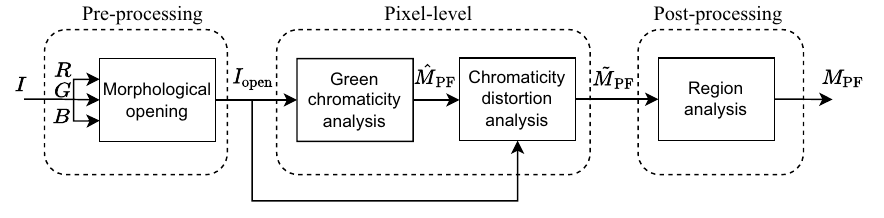
Figure 2. Block diagram of the proposed